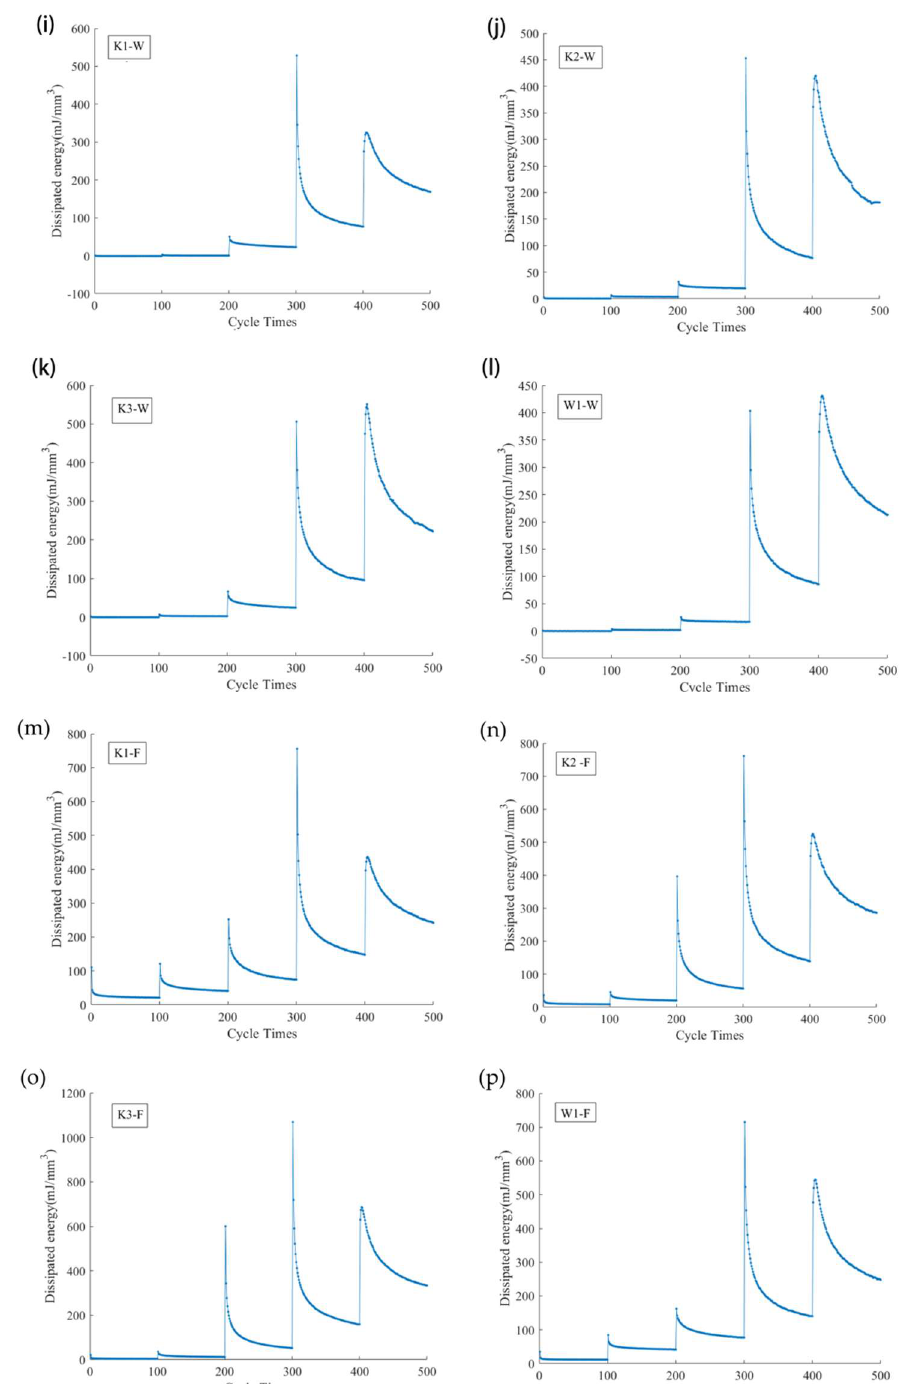
Figure 5. Energy variation curves with stress. ( a – d ) Total absorption strain energy and elastic strain energy of the warp direction of K 1 , K 2 , K 3 , and W 1 . ( e – h ) Total absorption strain energy and elastic strain energy of the fill direction of K 1 , K 2 , K 3 , and W 1 . ( i – l ) Dissipated energy of the warp direction of K 1 , K 2 , K 3 , and W 1 . ( m – p ) Dissipated energy of the fill direction of K 1 , K 2 , K 3 , and W 1